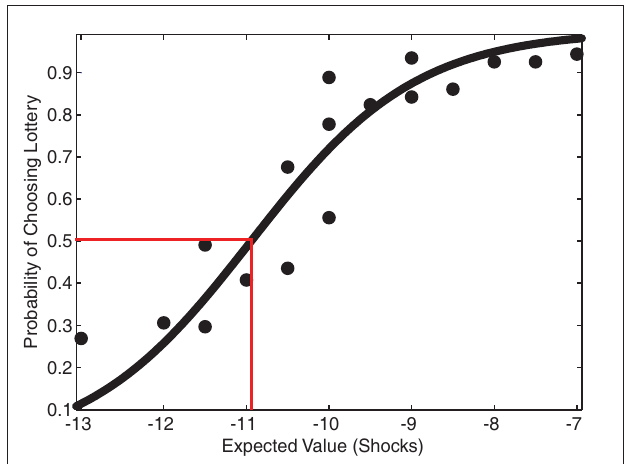
FIguRe 2 | Risk-seeking behavior. To analyze risk attitude, a sigmoid curve was fit to the lottery choice data using a logistic function. An indifference point at the status quo characterizes risk-neutral behavior. Participants’ actual estimated indifference point was at a lower expected value than the status quo, indicated by the red correspondence, which demonstrates risk-seeking behavior, typical in the realm of losses (Kahneman and Tversky, 1979). The reference point of 10 shocks ( − 10) did not lie within the 95% confidence interval of the logistic fit ( f ( − 10) = 0.720 ± 0.214), suggesting that this observed indifference point was significantly different from risk-neutrality.